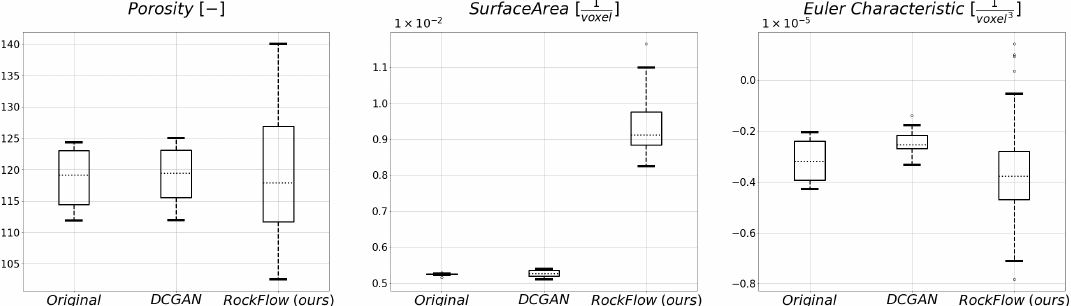
Figure 8. Comparison of Minkowski functionals among ground-truth images, DCGAN model, and the presented generative flow model for Ketton sample images for (left) porosity, (middle) surface area, and (right) Euler characteristic. The ground-truth and DCGAN data were evaluated on 200 3 image volumes and taken from [3]. The generative flow model was evaluated on 128 3 image